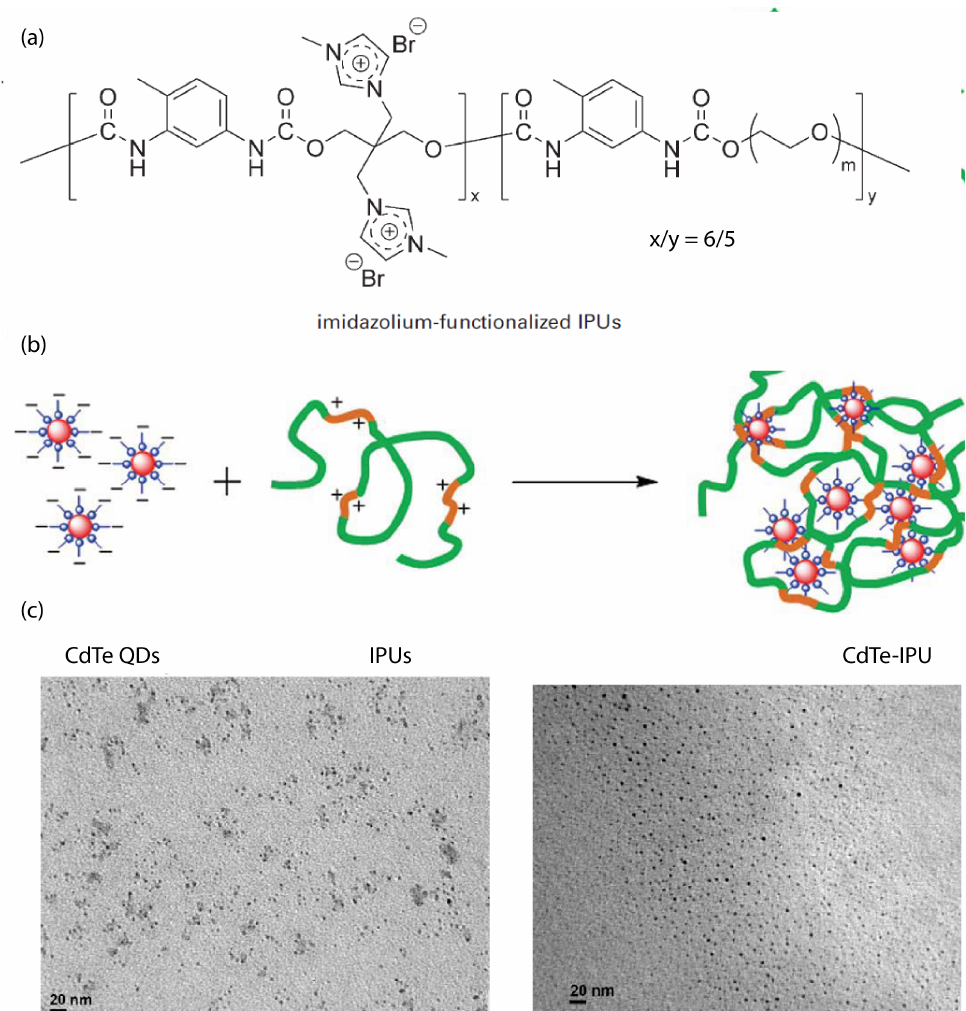
Figure 6. Quantum dot ionic polyurethane (iPU)—nanocomposite; ( a ) Imidazolium functionalized ionic Polyurethanes (iPUs). Reprinted with permission from Li et al. [89] ( b ) schematic prepara- tion process of the quantum dot ionic polyurethane (iPU)—nanocomposite, (c ) TEM images of the nanocomposite. Reprinted with permission from Li et al.